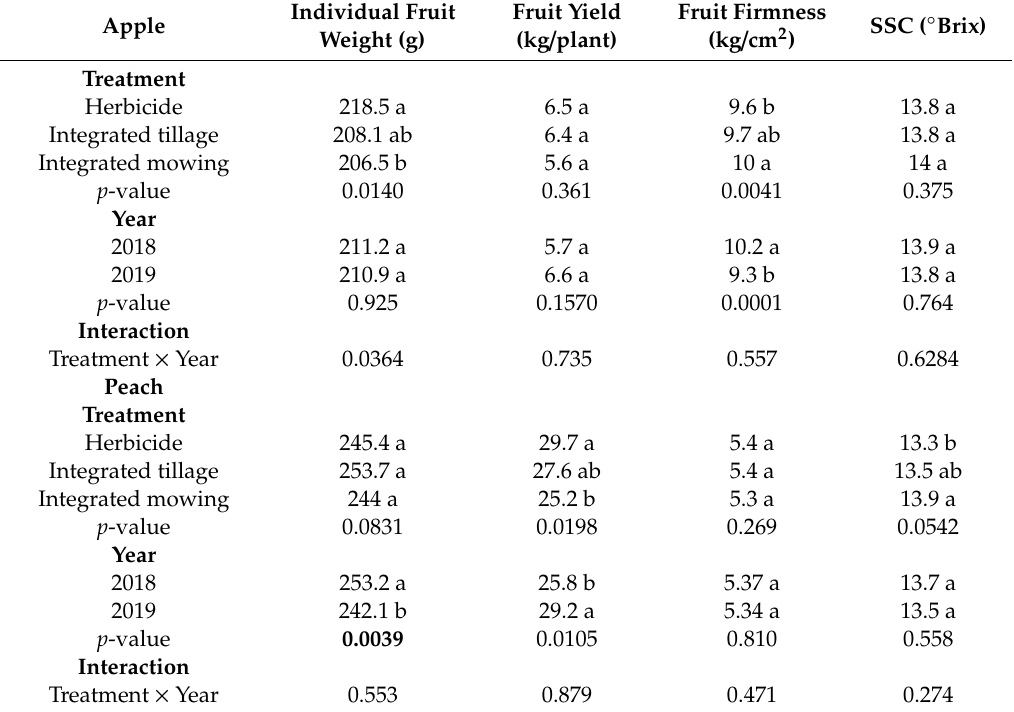
Table 5. E ff ects of integrated weed control methods, year and their interactions on apple and peach yield and quality